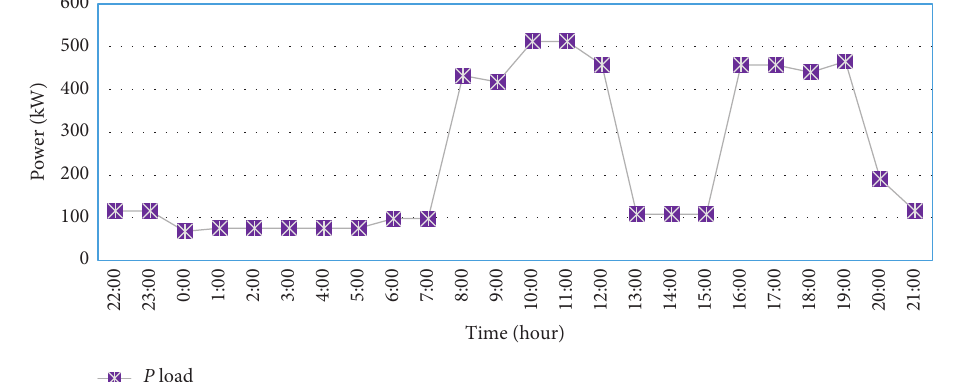
Figure 5: Ship’s load power profile for 24 hours.